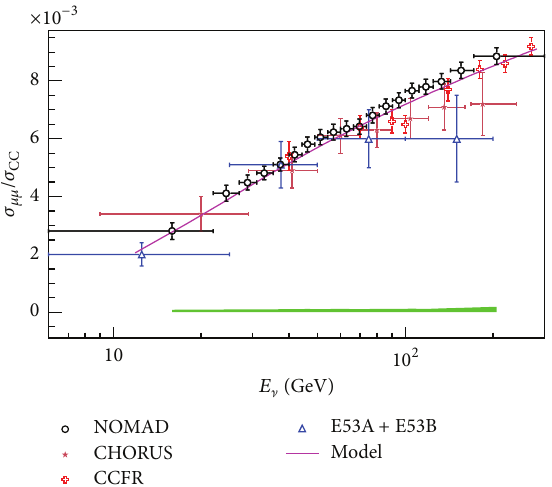
Figure12:Ratiobetweencharmdimuoncross-sectionandinclusive ] 𝜇 CC cross-section from NOMAD (from [29]). Previous measure- ments are also